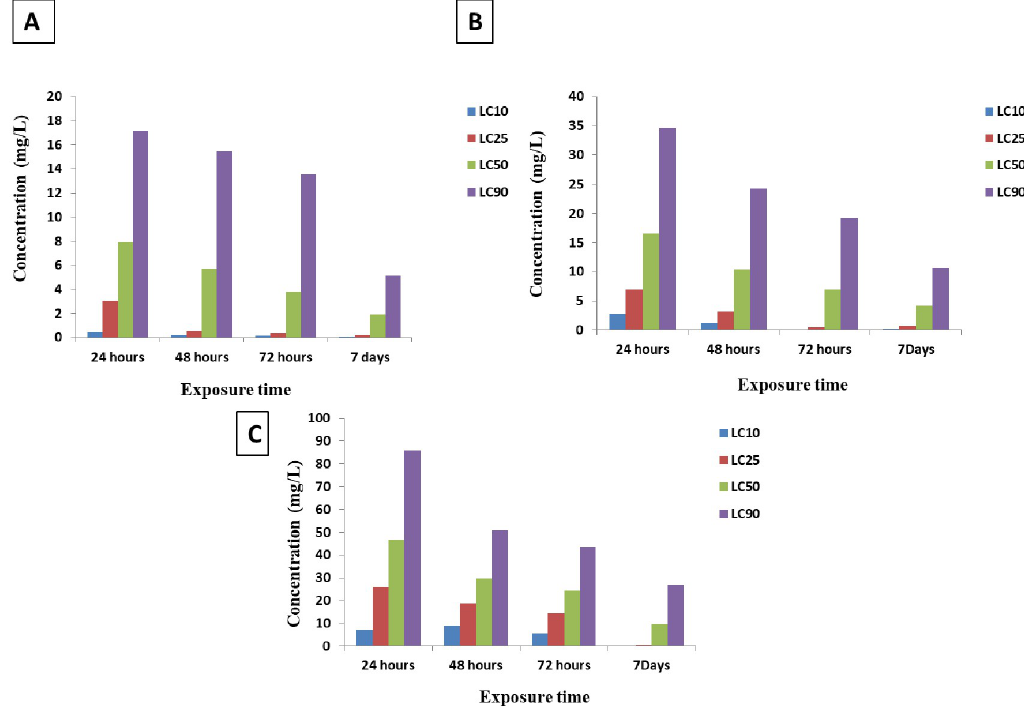
Fig 2. Differentiation of molluscicidal efficacy of Ag-NPs against A: Biomphalaria alexandrina , B: Biomphalaria glabrata and C: Oncomelania hupensis snail at different time point (24, 48, 72hrs and 7 days).